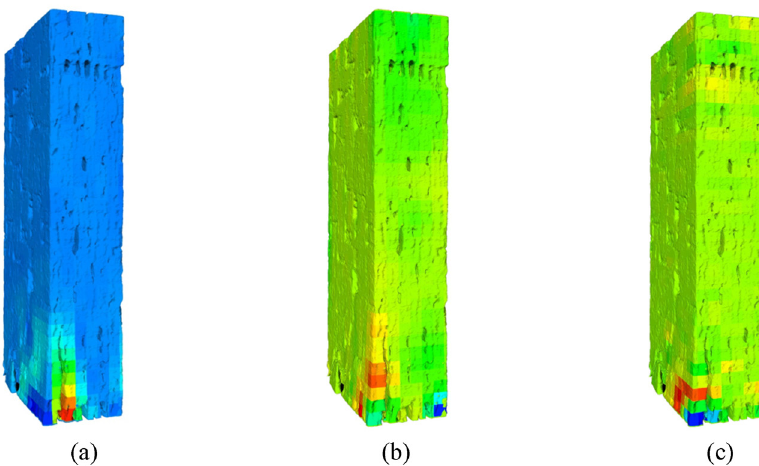
Figure 9: Strain distribution under maximum loading calculated by DVC: ( a ) X - direction, ( b ) Y - direction, and ( c ) Z - direction.